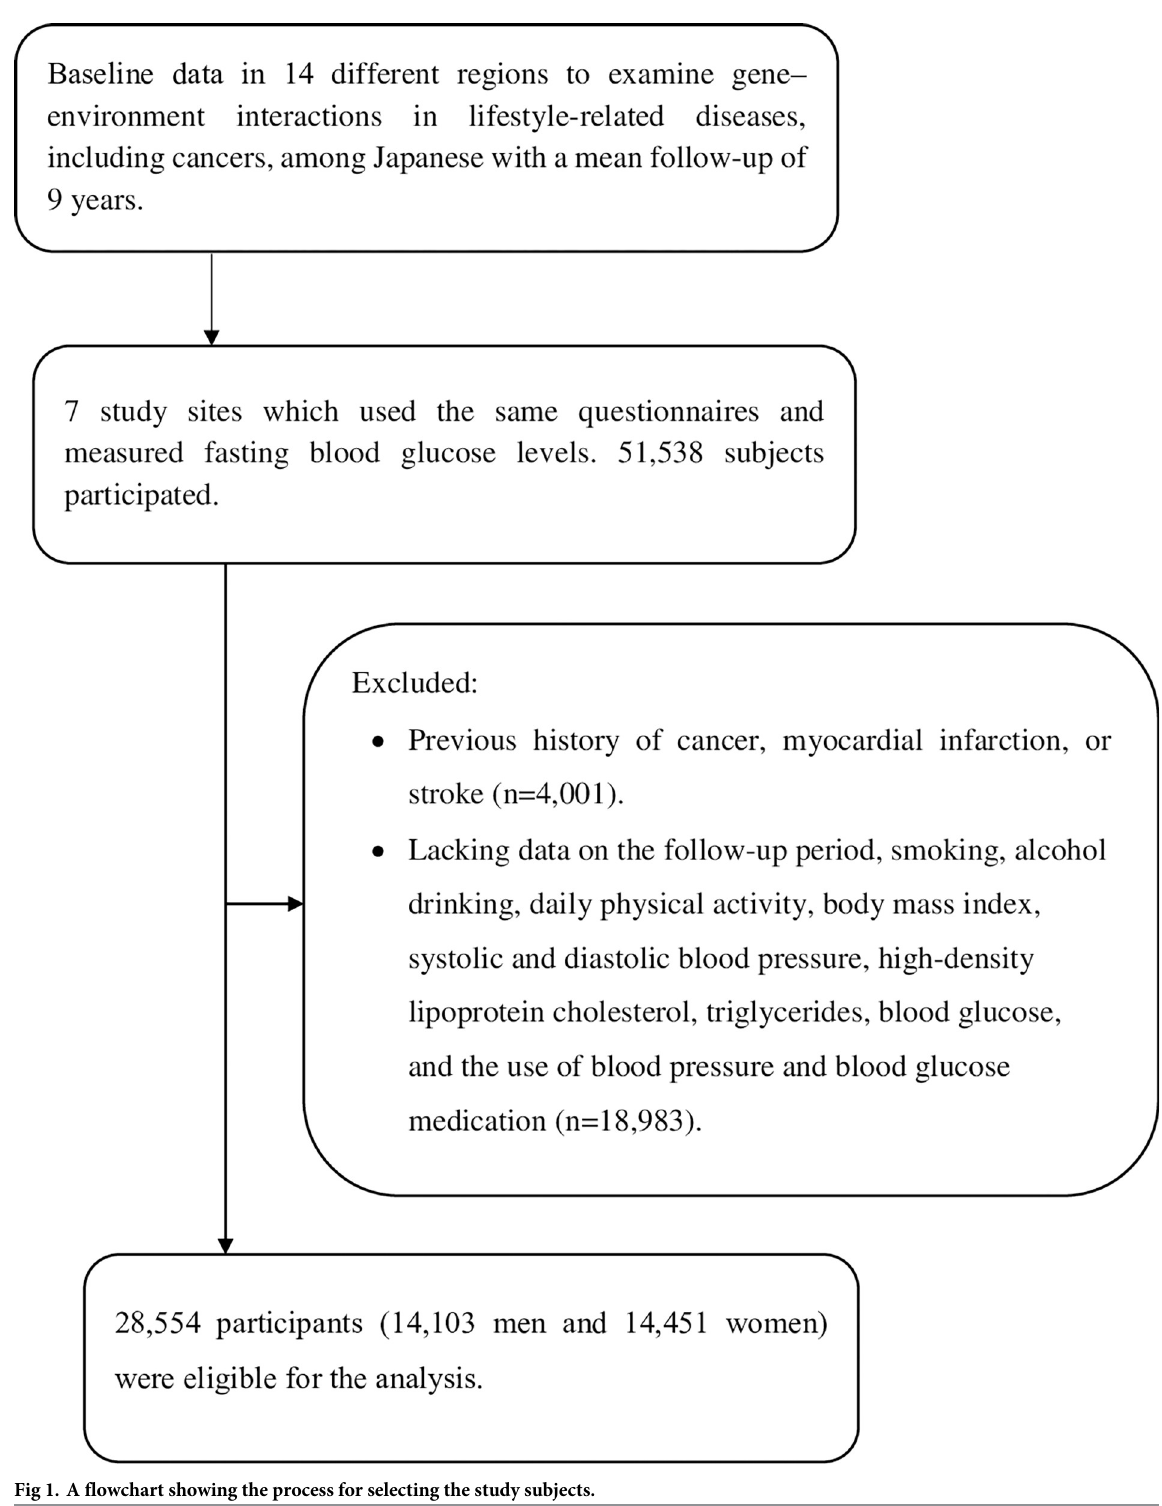
Fig 1. A flowchart showing the process for selecting the study subjects.